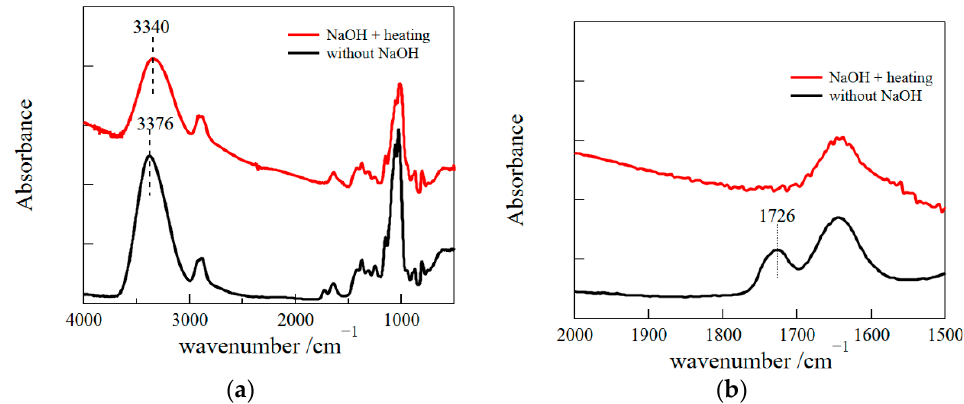
Figure 3. FTIR spectra for freeze-dried samples of GM gels prepared by adding NaOH and heating and for freeze-dried samples of GM aqueous solutions without NaOH ( a ) and the magnification ( b ).